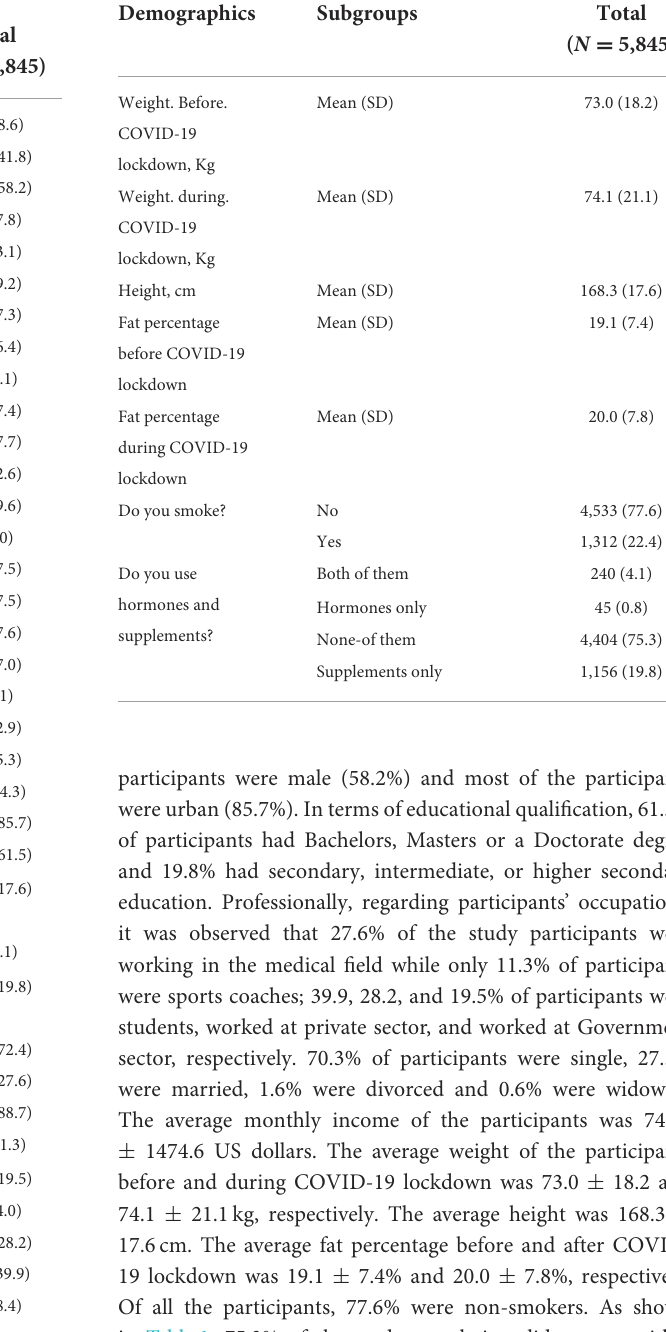
TABLE 1 Baseline demographic characteristics among study